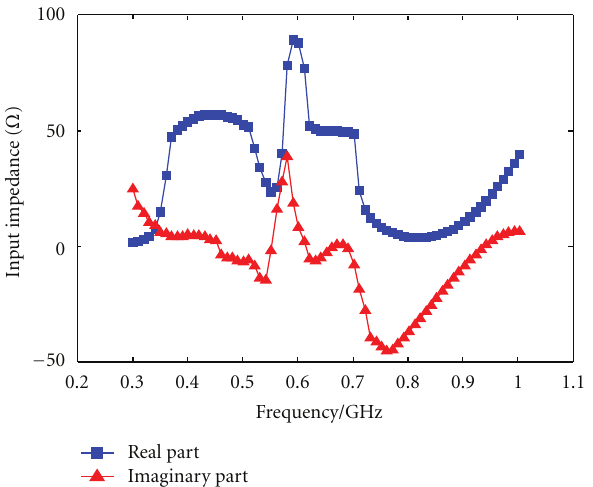
Figure 6: Input impedance of the Peano fractal antenna.